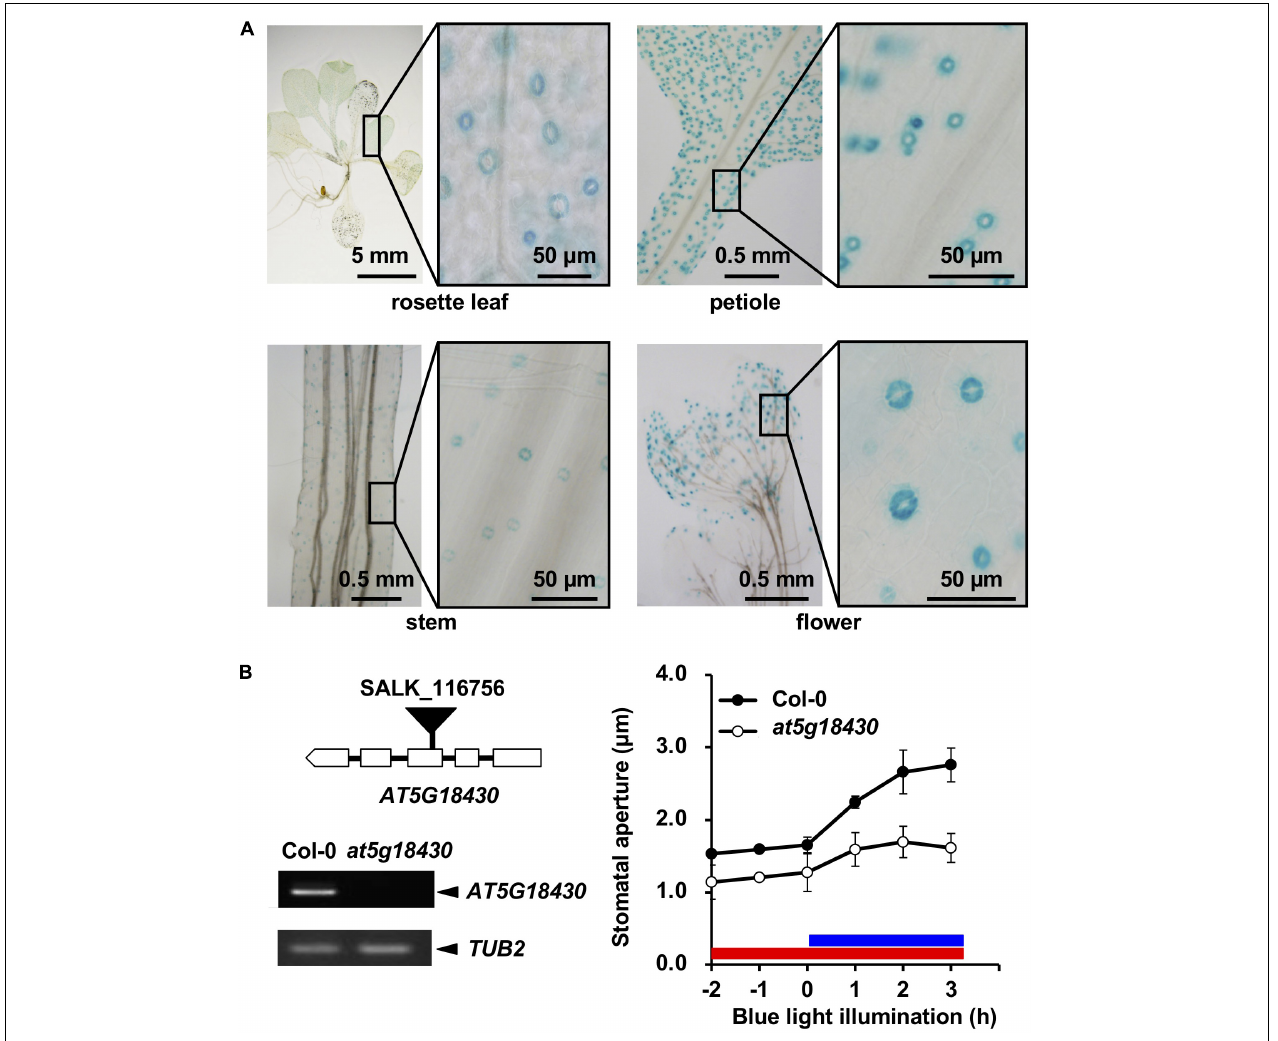
FIGURE 2 | Expression of At5g18430 and the stomatal phenotype of the at5g18430 mutant. (A) Expression pattern of At5g18430 in GUS-reporter-bearing plants. (B) The stomatal phenotype of the at5g18430 mutant. Left: A schematic of the T-DNA insertion site in at5g18430 and the transcript levels in leaves. Right: blue light (BL)-induced stomatal opening in Col-0 and at5g18430 epidermal tissues. The red bar indicates the red light (RL) illumination period (50 µ mol m − 2 s − 1 ). The blue bar indicates the BL illumination period (10 µ mol m − 2 s − 1 ). Epidermal tissues were incubated in 50 mM KCl, 0.1 mM CaCl 2 , and 10 mM Mes-BTP (pH 6.5). Averages from three independent experiments are shown. Error bars: SDs ( n = 3).